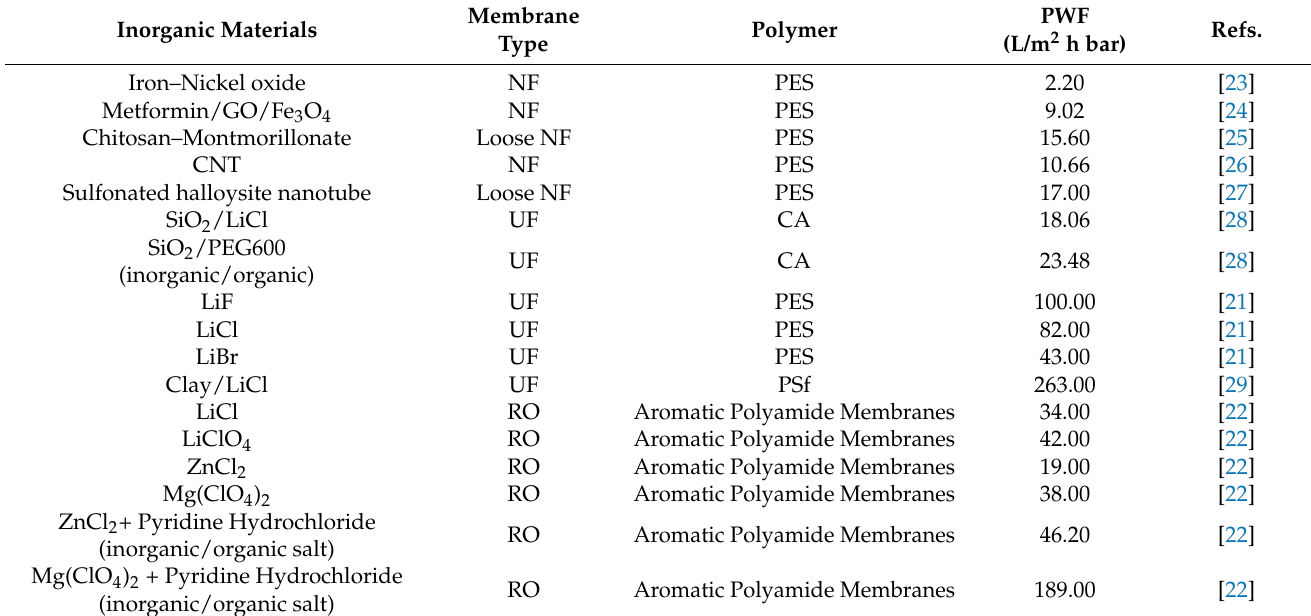
Table 3. Different inorganic and mixed inorganic/organic materials incorporated as